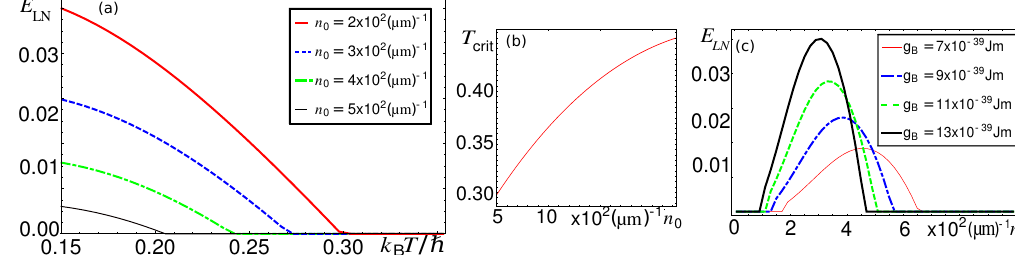
Figure 5: Dependence of the entanglement between the two kinds of impurities on the density of the bosons in the bath. In (a) we study entanglement as a function of T for various densities of bosons. As shown, in this range of densities, increasing the density of bosons enhances entanglement. For each density, at certain T , the crit entanglement vanishes. The dependence of T as a function of density is shown crit in (b). In (c) we illustrate that the entanglement at fixed T increases for a range of n and then decreases to zero, as it was the case with η in Fig. 1. We show this 0 2 dependence for various values of the coupling constant among the bosons. As shown, increasing g increases the maximum value of the entanglement reached, but also B entanglement vanishes at a smaller value of the density. In all of the graphs, we are considering impurities of potassium K in a bath of particles of Rubidium Rb. The = 600 π Hz , Ω = 450 π Hz , η = 0.325, η = 0.295, T = 4.35 nK , parameters are: Ω 1 2 1 2 = 2.36 · 10 − 38 J · m and R / a = g B 12 HO